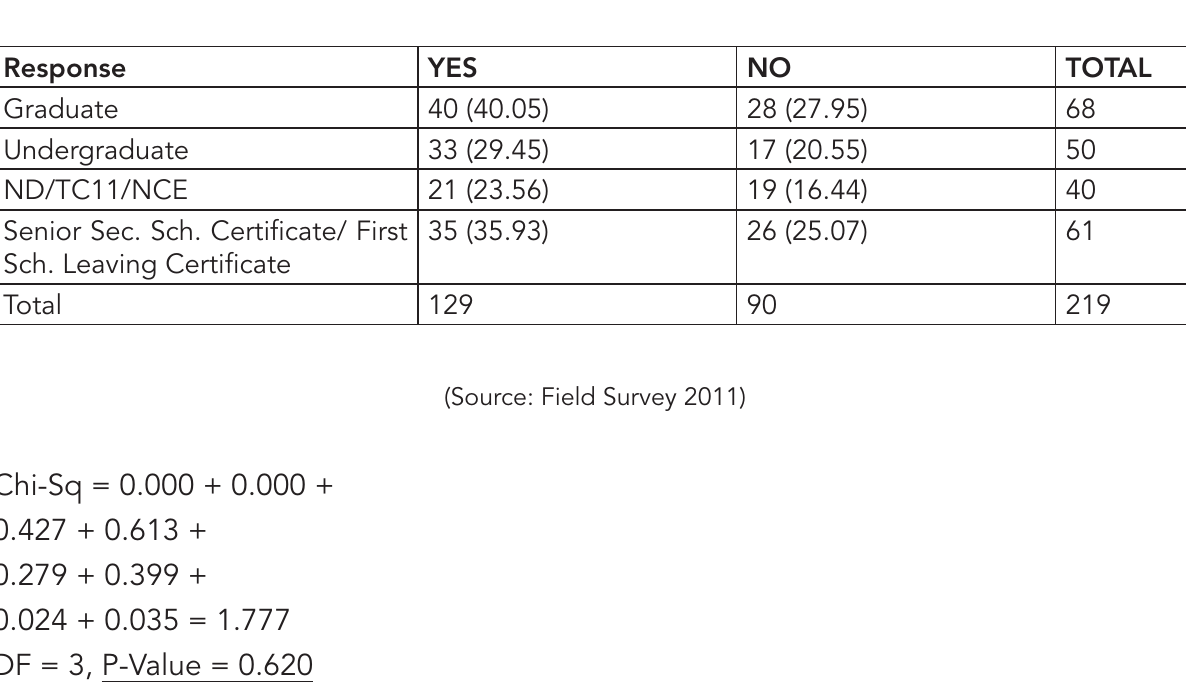
Table 4: Comfort of